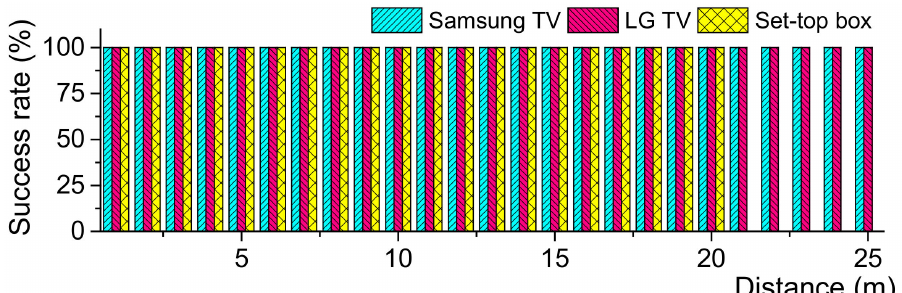
Figure 8. Response success rate according to